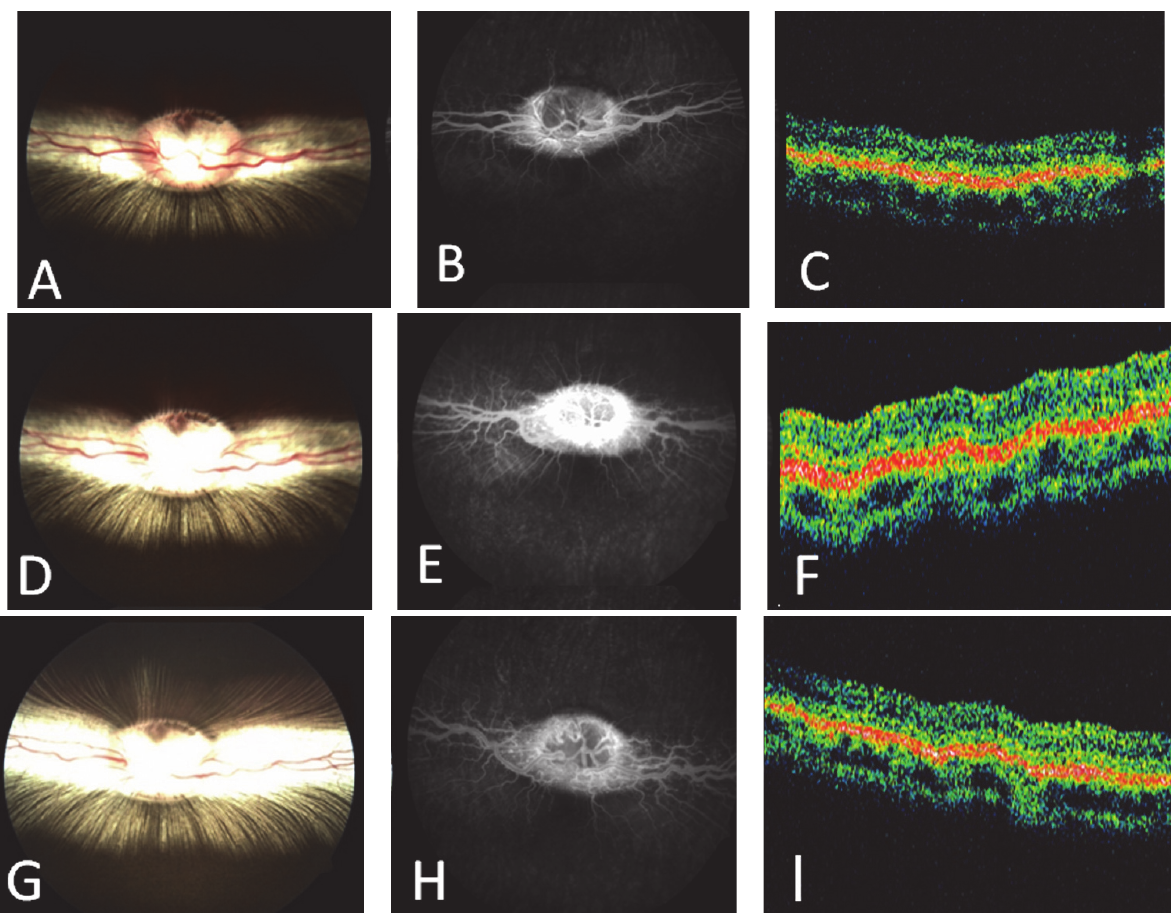
Figure 1: Color fundus photographs, fundus fluorescein angiography, and optical coherence tomography (OCT) from the baseline (A, B, and C), 3 months (D, E, and F), and 6 months follow-up (G, H, and I). There were no retinal or optic disc abnormalities in the study rabbits during the follow-up